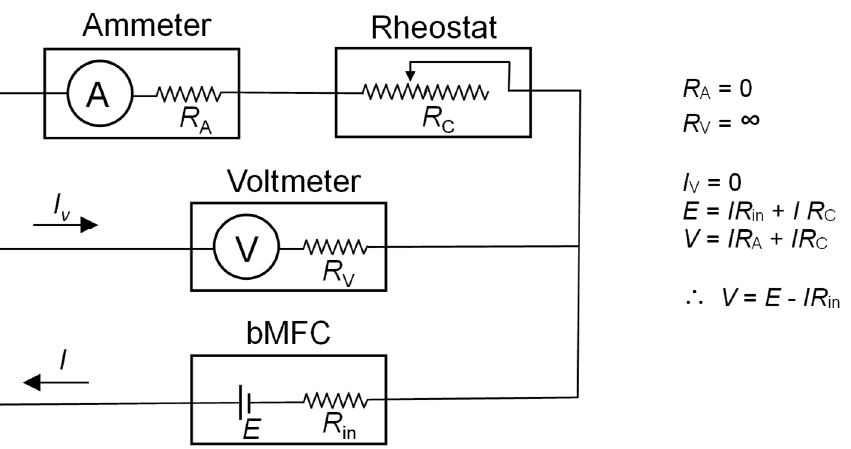
Figure A1. Circuit for determining the internal resistance and electromotive force of bMFC. The electric circuit was designed to estimate the internal resistance of the bMFC. R A , R V , R C , and R in denote the internal resistance values of the ammeter, voltmeter, rheostat, and bMFC, respectively. “ I ” denotes the current value in the line and “ E ” denotes the electromotive force. In the apparatus, R A was considered negligibly small and R V was considered infinite.